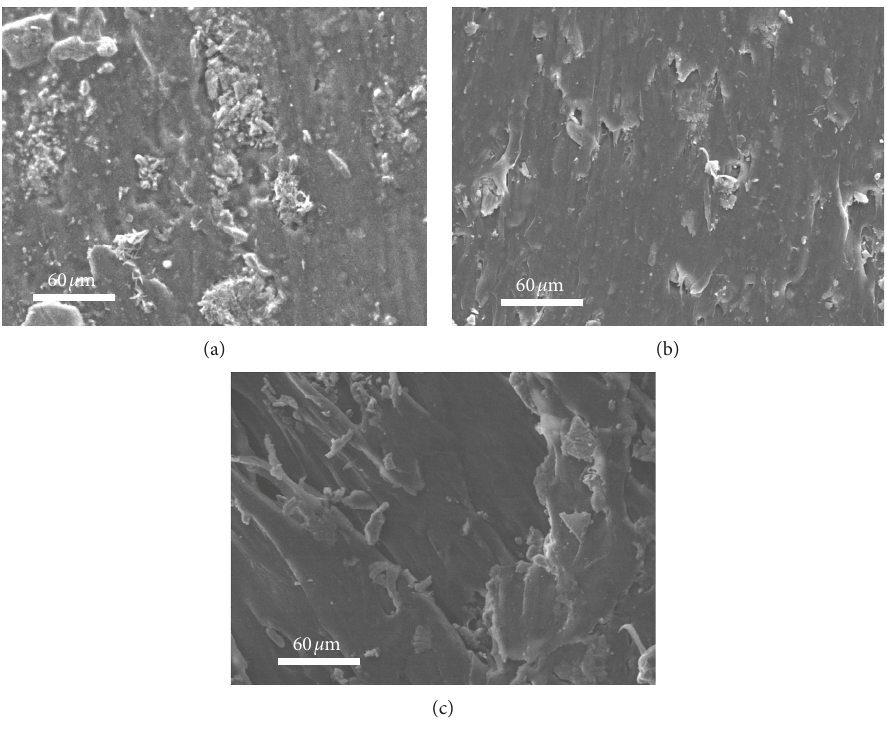
Figure 6: SEM ( 500) of (a) IFR-PP (PER), (b) IFR-PP (PEPA), and (c) IFR-PP (PBPP). ×